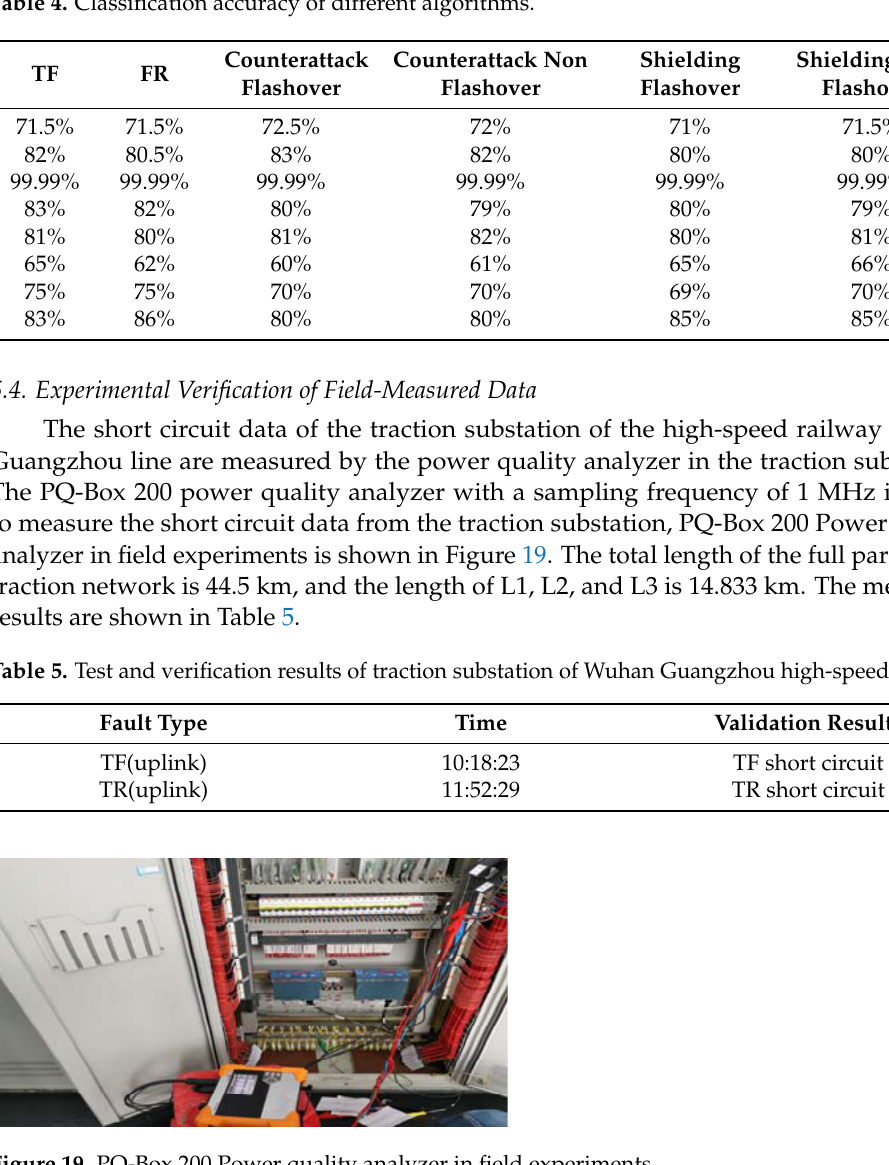
Table 4. Classification accuracy of different algorithms.